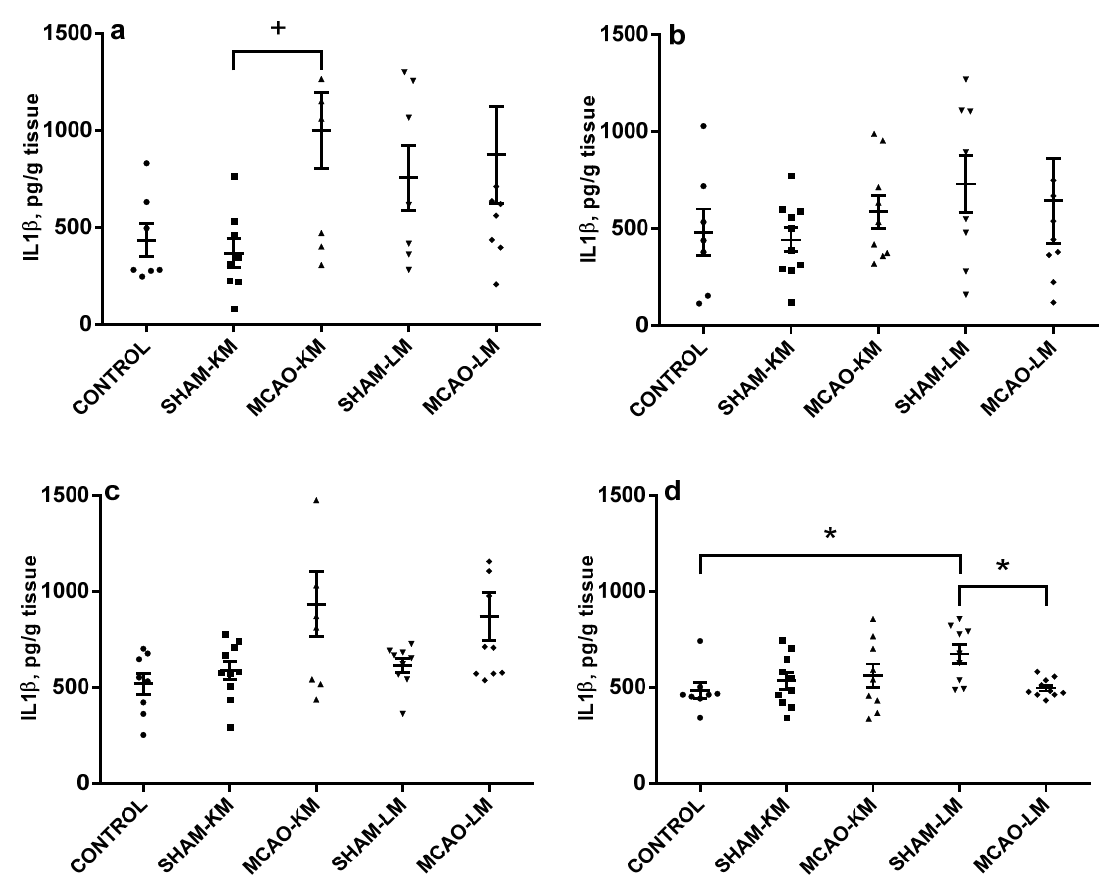
Figure 4. IL1 β levels in the hippocampus ( a , b ) and FC ( c , d ) in MCAO-KM and MCAO-LM groups 3 days after surgery. ( a ) Ipsilateral hippocampus. ( b ) Contralateral hippocampus. ( c ) Ipsilateral FC. ( d ) Contralateral FC. ( a – d ) IL1 β , pg/g tissue. * p < 0.05 and + p < 0.1 compared to the respective sham-operated groups or control rats.